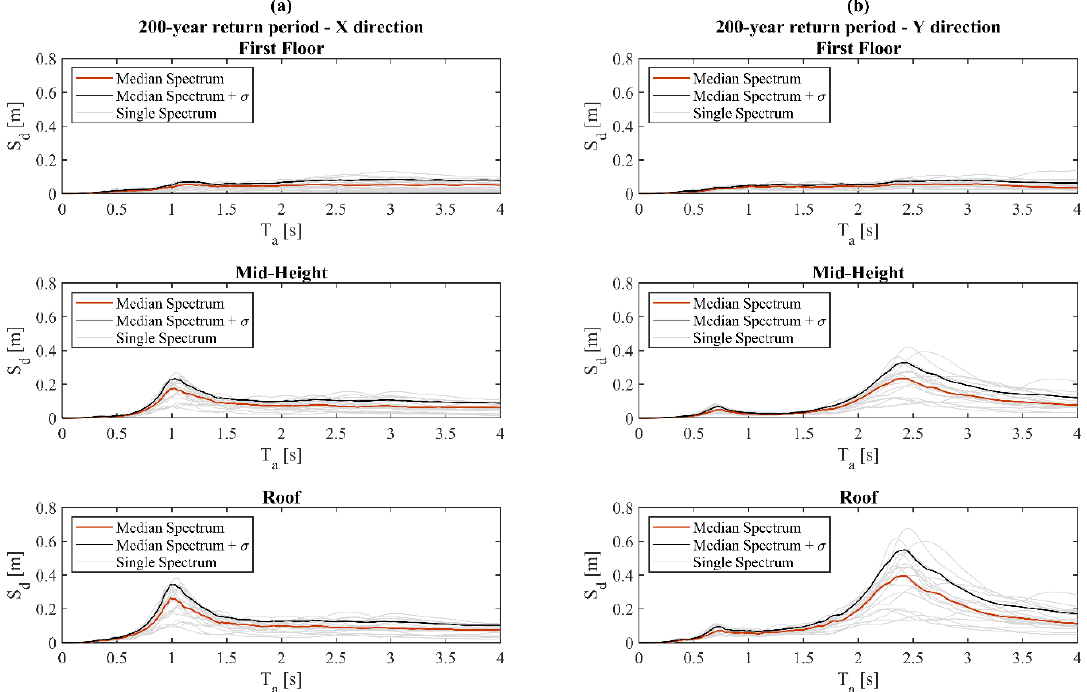
Figure 9. Displacement floor spectra for RP = 200 years—First floor, mid-height and roof: ( a ) longitudinal, X direction; ( b ) transverse, Y direction.